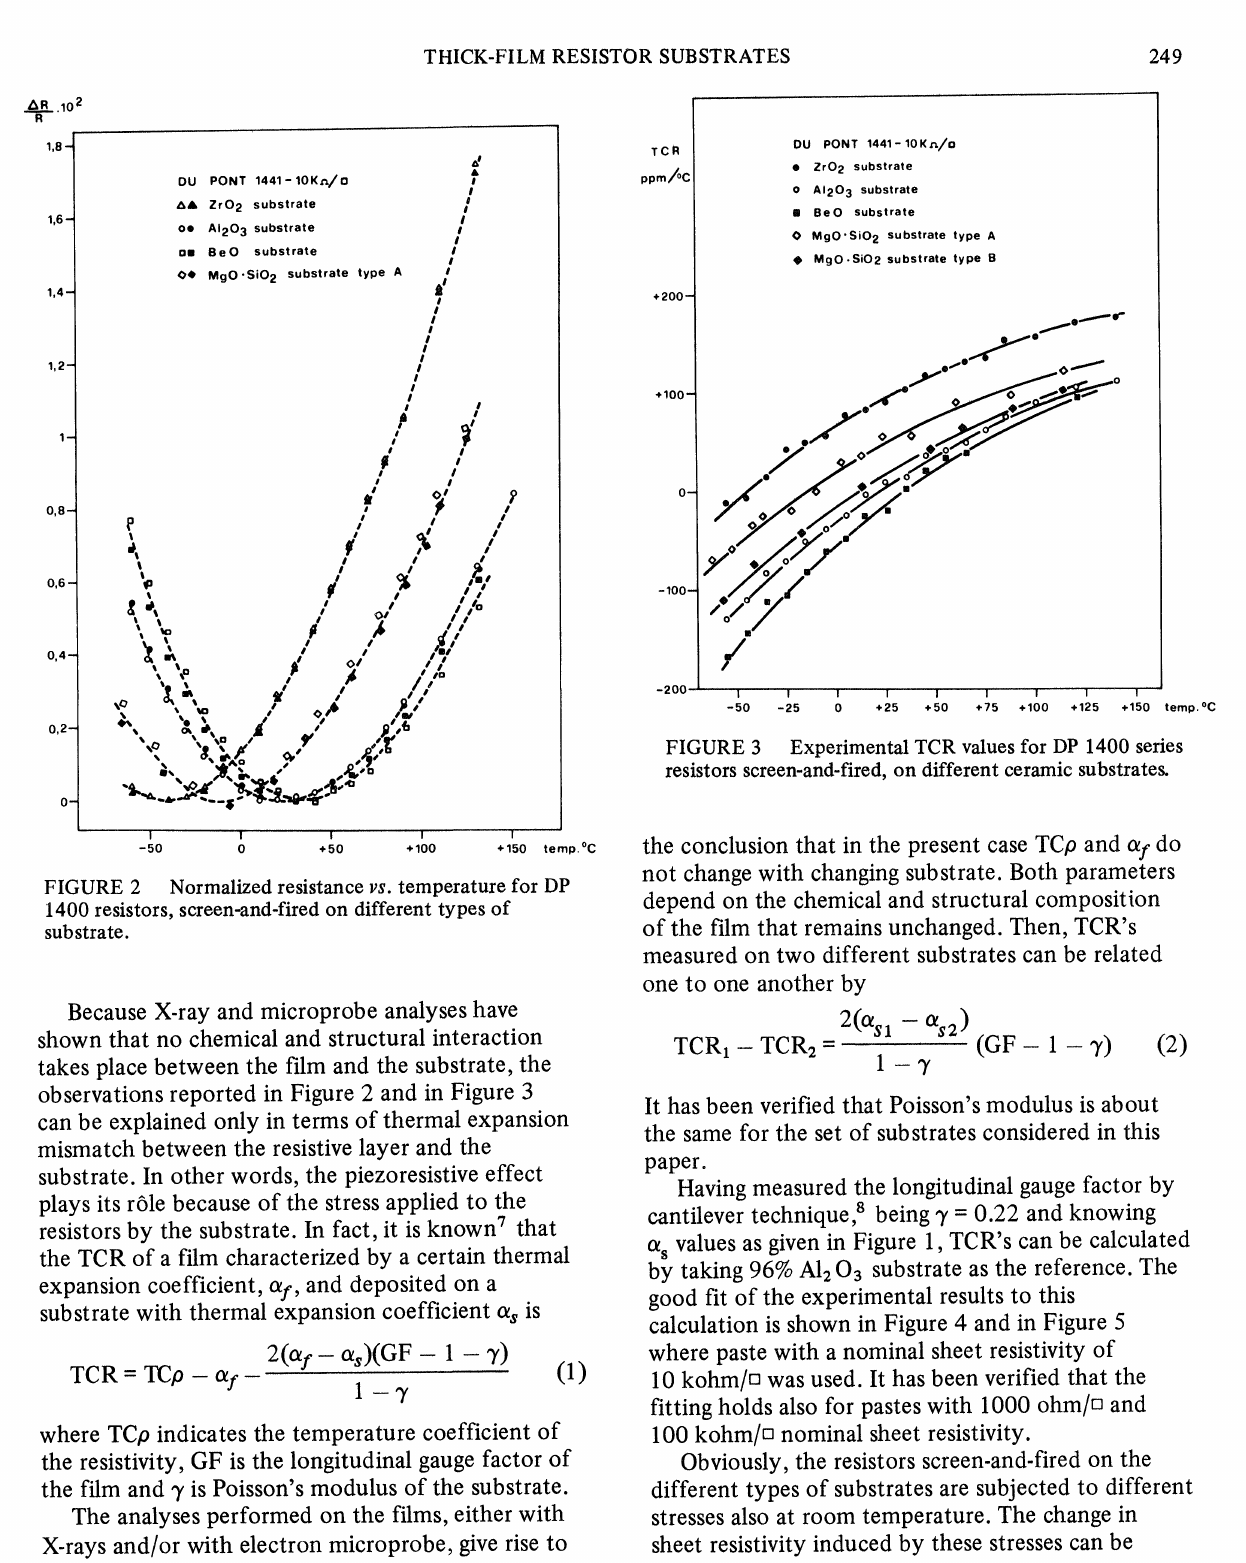
FIGURE 2 Normalized resistance vs. temperature for DP 1400 resistors, screen-and-fired on different types of substrate.